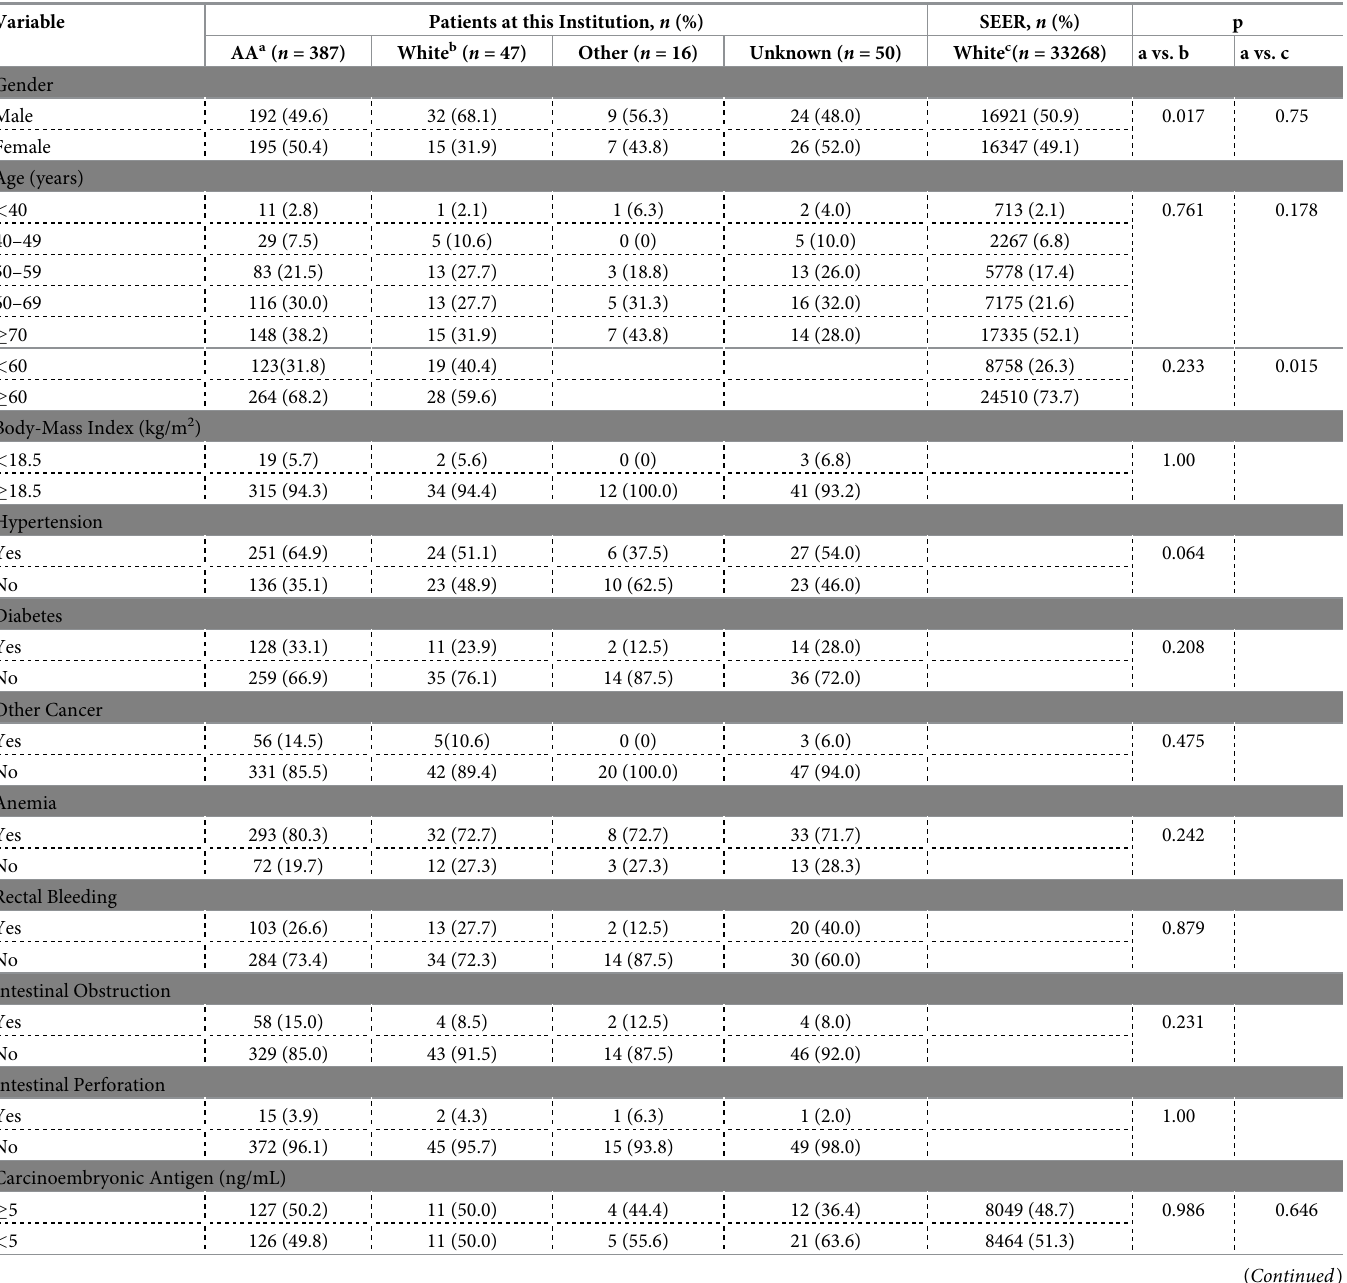
Table 1. Clinicopathologic features of colorectal carcinoma in patients of different